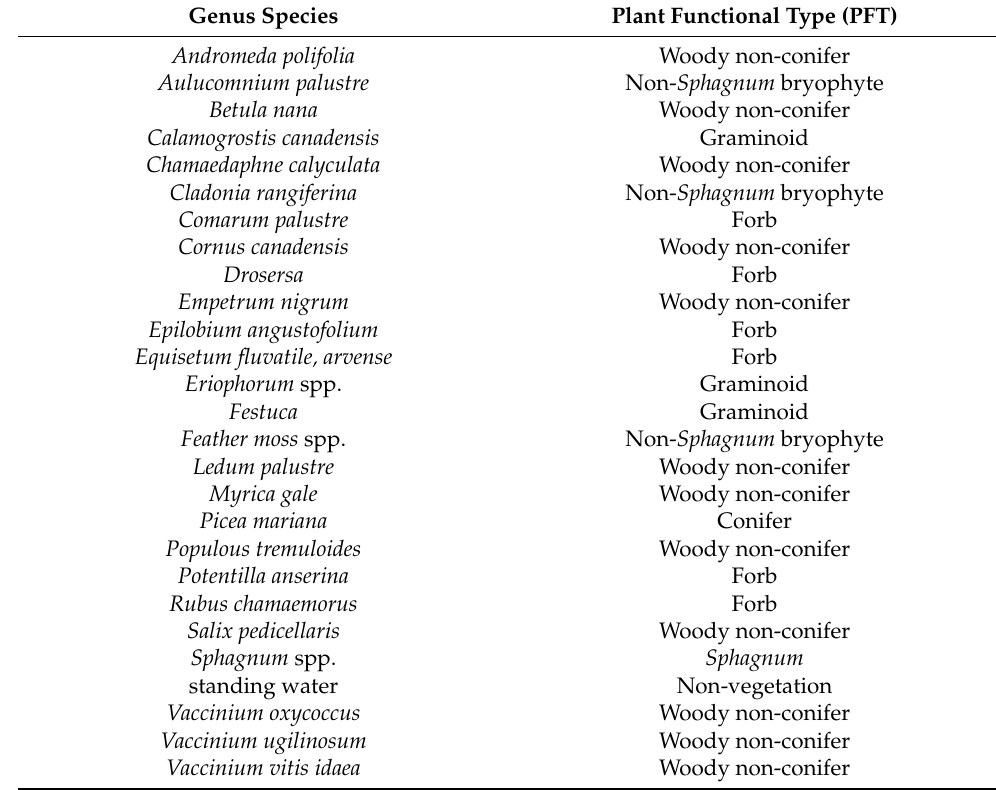
Table 2. Taxa sampled across all sites, classified into